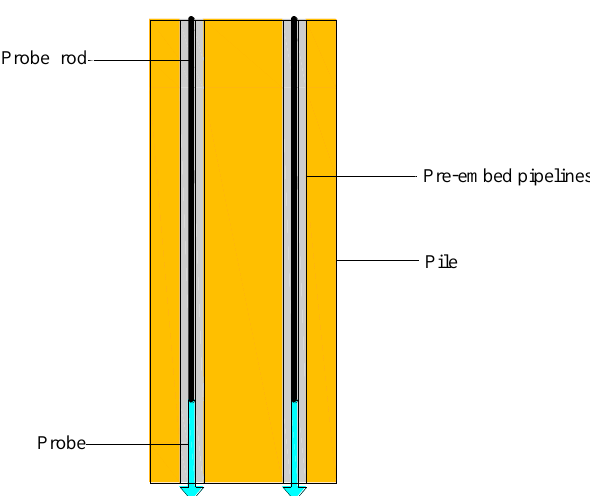
Figure 6. Dynamic penetration device of pile base grouting effect